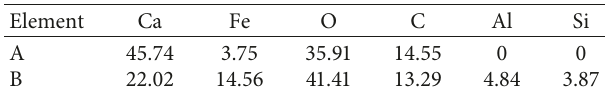
Table 5: Element content